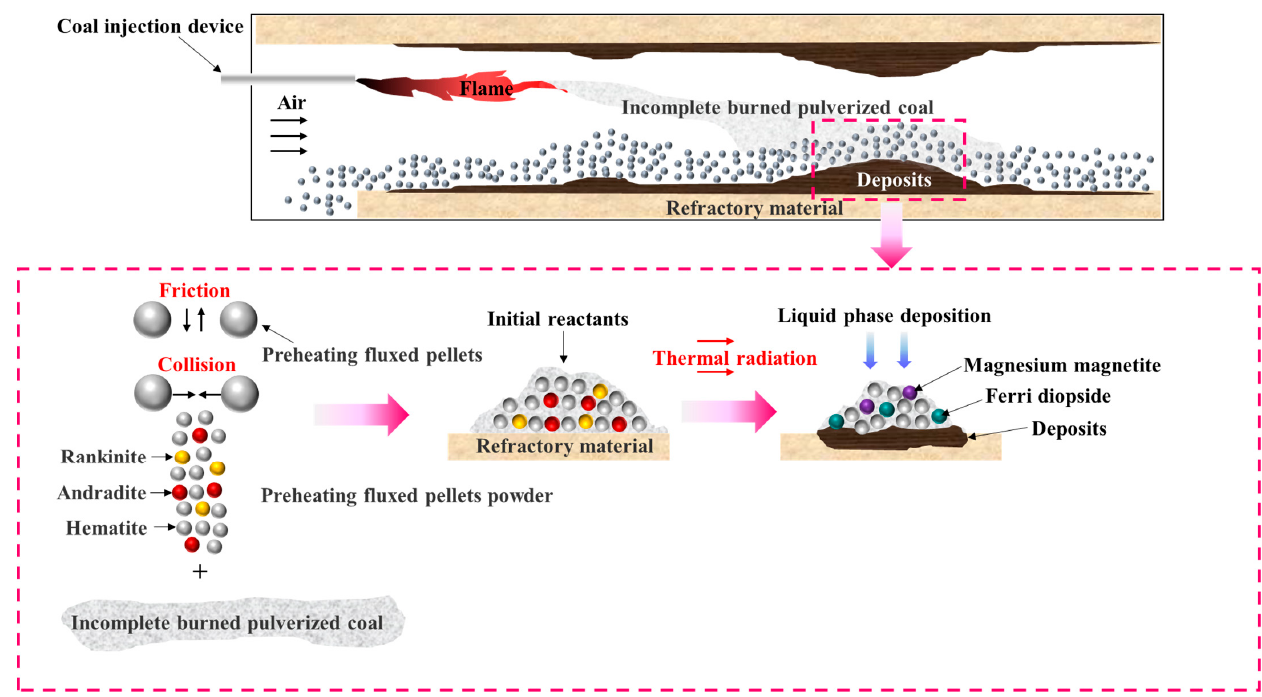
Figure 9. Schematic diagram of the deposit formation process for magnesium fluxed pellets.